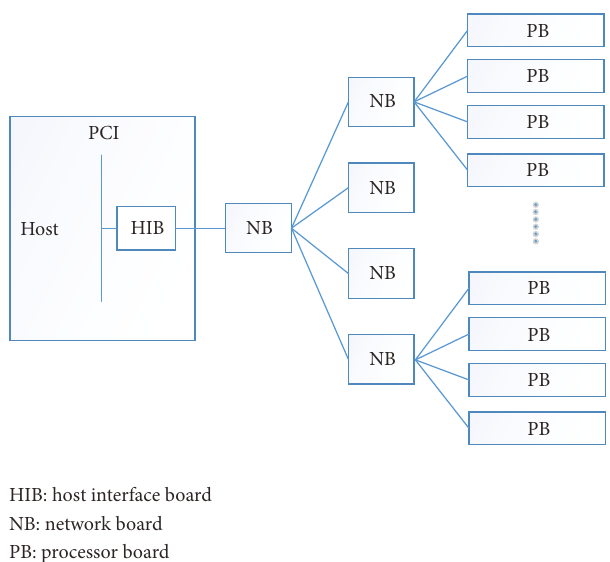
Figure 2: GRAPE computing